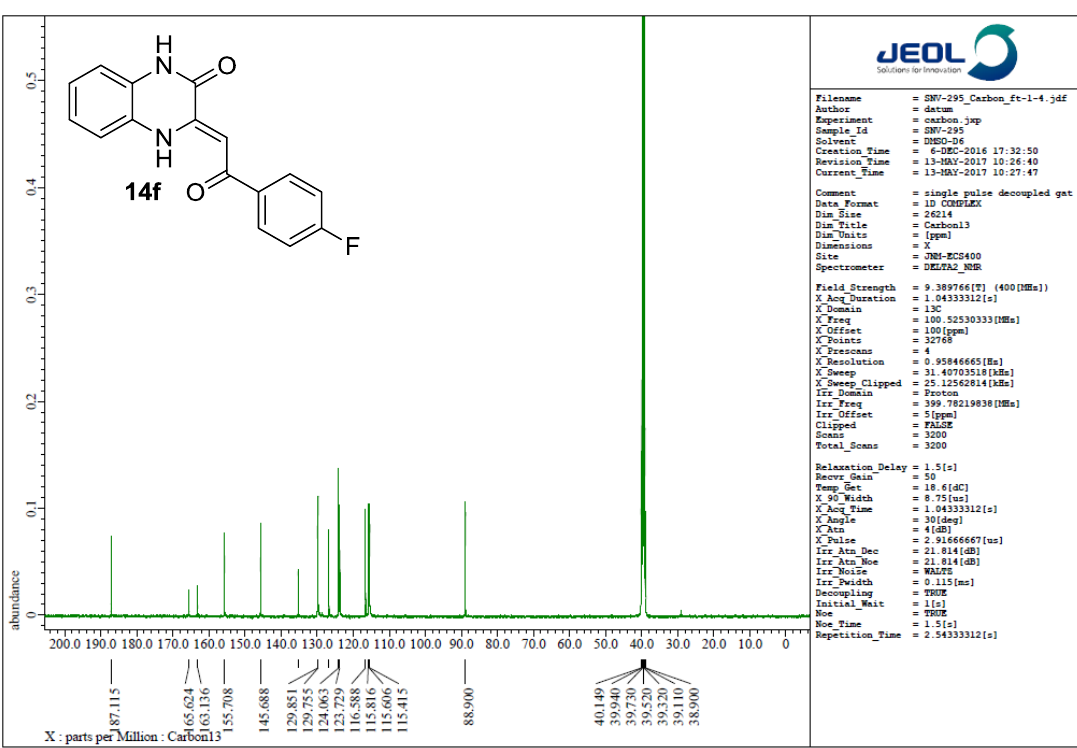
Figure 40 . 13 C NMR Spectra of Compound 14f